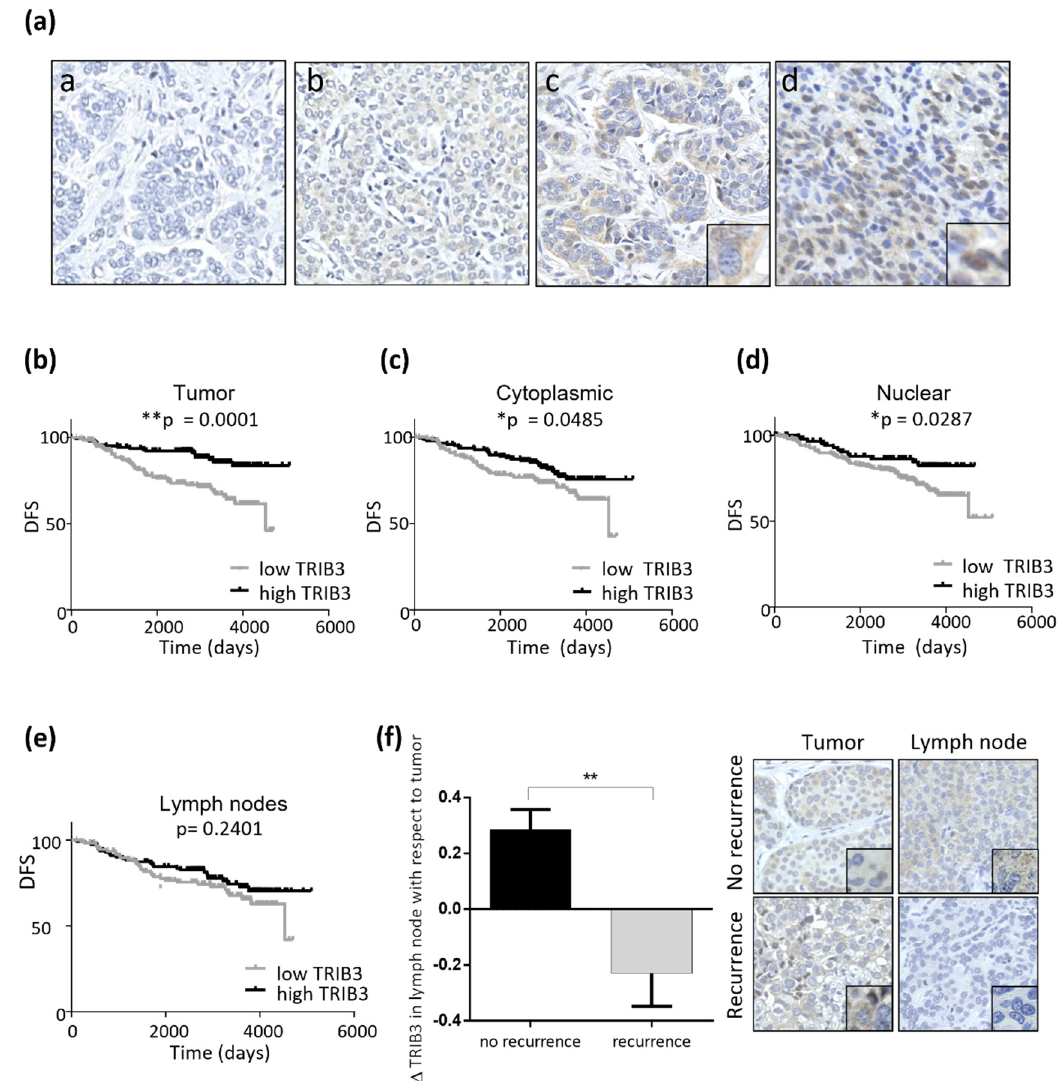
Figure 5. High TRIB3 protein levels are associated to good prognosis in luminal breast cancer patients. ( a ) The representative images (40 × ) of the pattern of TRIB3 immunostaining in samples from a tissue microarray of luminal breast cancer patients ( a : negative/non-detectable, b : low intensity, c : medium intensity cytoplasmatic staining (see inset–6X digital amplification—for details), and d : high intensity showing a mainly nuclear staining pattern (see inset–6X digital amplification—for details). ( b – d ) Kaplan-Meier representation of disease-free survival (DFS) according to the intensity of TRIB3 immunostaining in the primary breast tumor. Panel b considers TRIB3 protein levels irrespective of their cytoplasmic or nuclear localization whereas panels c and d correspond to the intensity of the cytoplasmic ( c ) or nuclear ( d ) TRIB3. ( e ) Kaplan-Meier curves representation of DFS according to the intensity of TRIB3 immunostaining in the affected lymph nodes. The samples were stratified as TRIB3 high- or low-levels by using the median value ( n = 291; * p < 0.05, ** p < 0.01 by log-rank test Mantel-Cox). ( f ) Left panel: The correlation between TRIB3 levels in the affected lymphatic node with respect to the primary tumor and the recurrence of the disease ( n = 291; ** p < 0.01 by Kolmogorov-Smirnov Test). Right Panel: microphotographs (40 × ) of TRIB3 staining of the primary tumor and affected lymphatic node see inset–6 × digital amplification—for details) of two patients that were representative of the non-recurrence and recurrence groups, respectively.